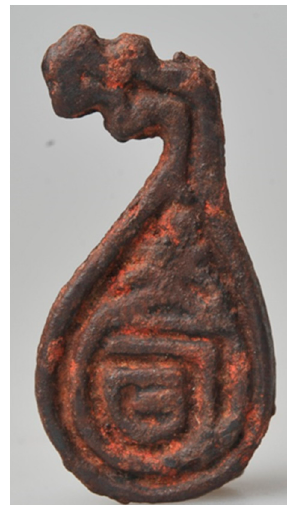
Figure 19. A Song Yuan Huaya in the shape of Hu Pipa with crooked neck and abstract motif. The period of the Song and Yuan Dynasties. Inventory number: HKU.m.61.936. Copyright © the database of the University Museum and Art Gallery of the University of Hong Kong.